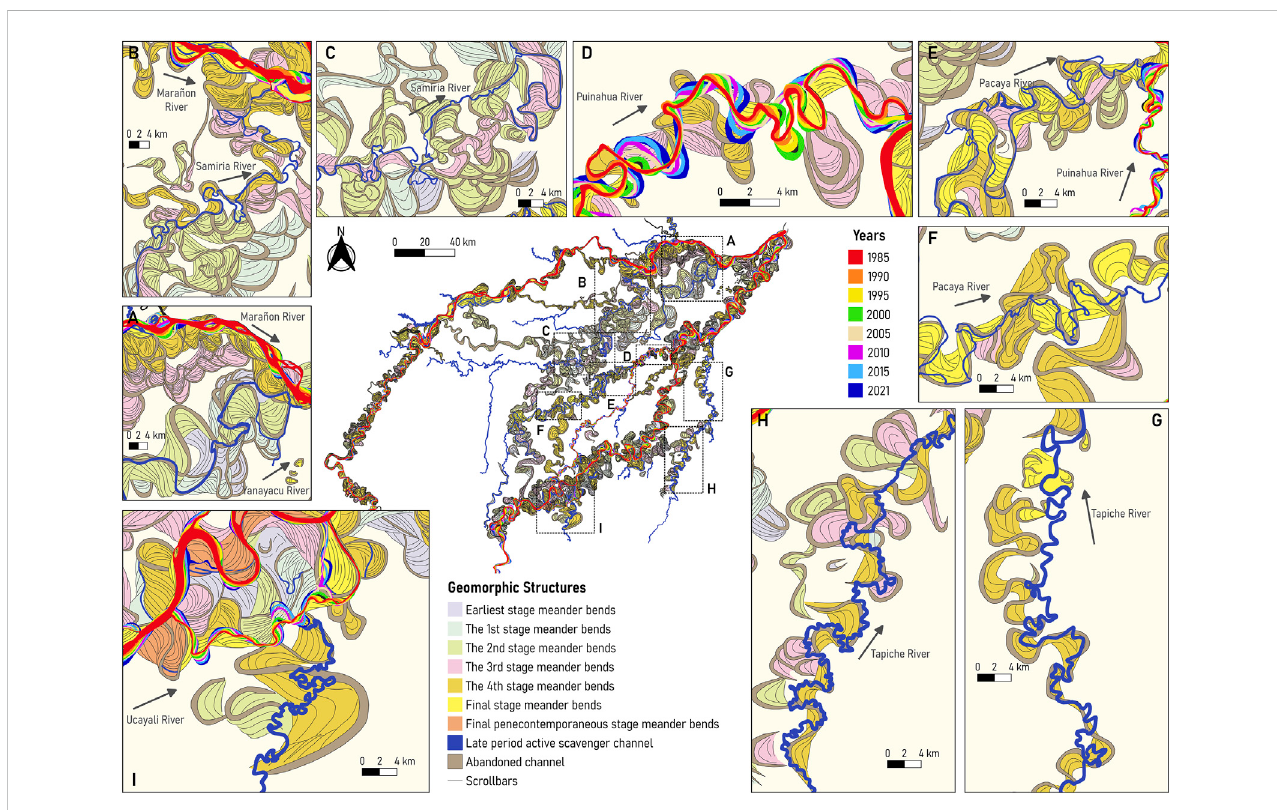
FIGURE 5 Free and under fi t-scavenger river dynamics in the P-S wetland: (A) ] Yanayacu River, (B,C) Samiria River, (D) Puinahua River, (E) con fl uence between the Pacaya and Puinahua Rivers, (F) Pacaya River, (G,H) Tapiche River, and (I) Sungaro River.